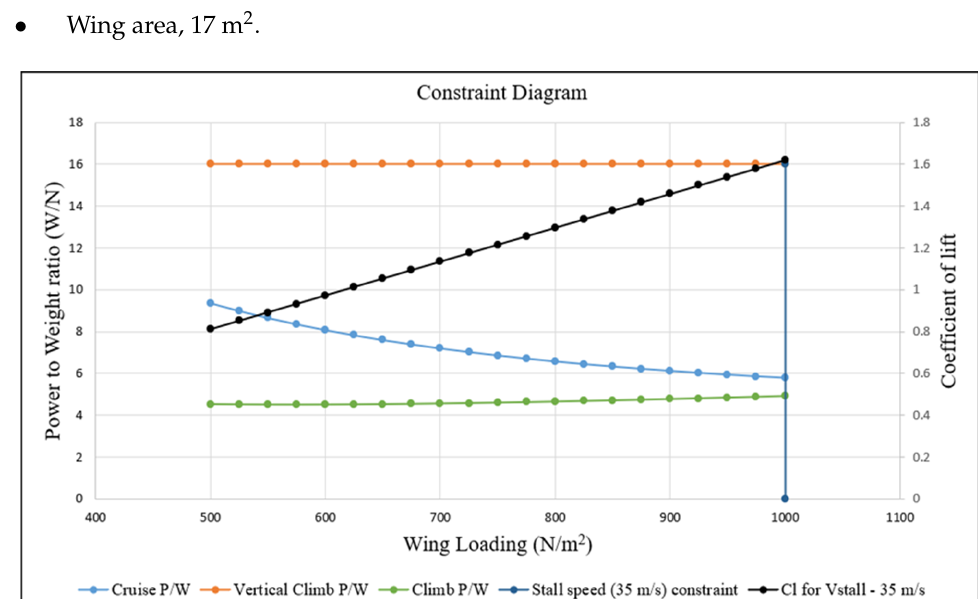
Figure 13. Constraint analysis diagram.